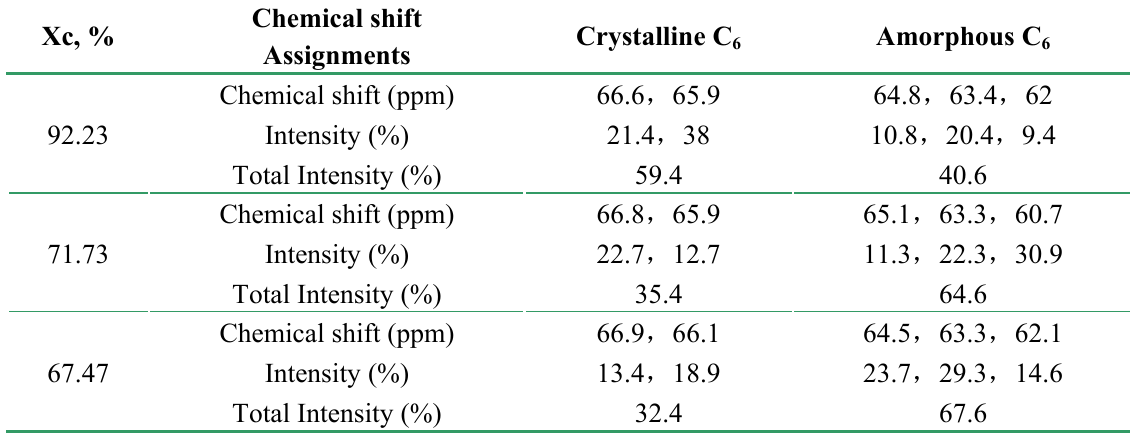
Table 3. Assignments and Intensity of Non-linear Least-squares fitting of the C the CP/MAS 13 C-NMR Spectra from MCC with different crystalline